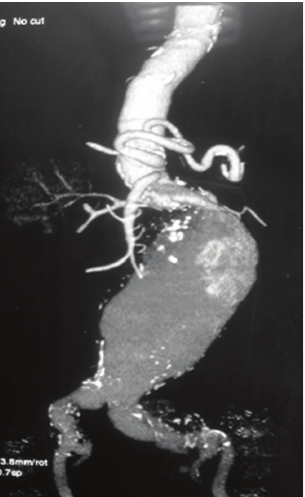
Figure 2: CT angiography of the anatomy of the AAA.